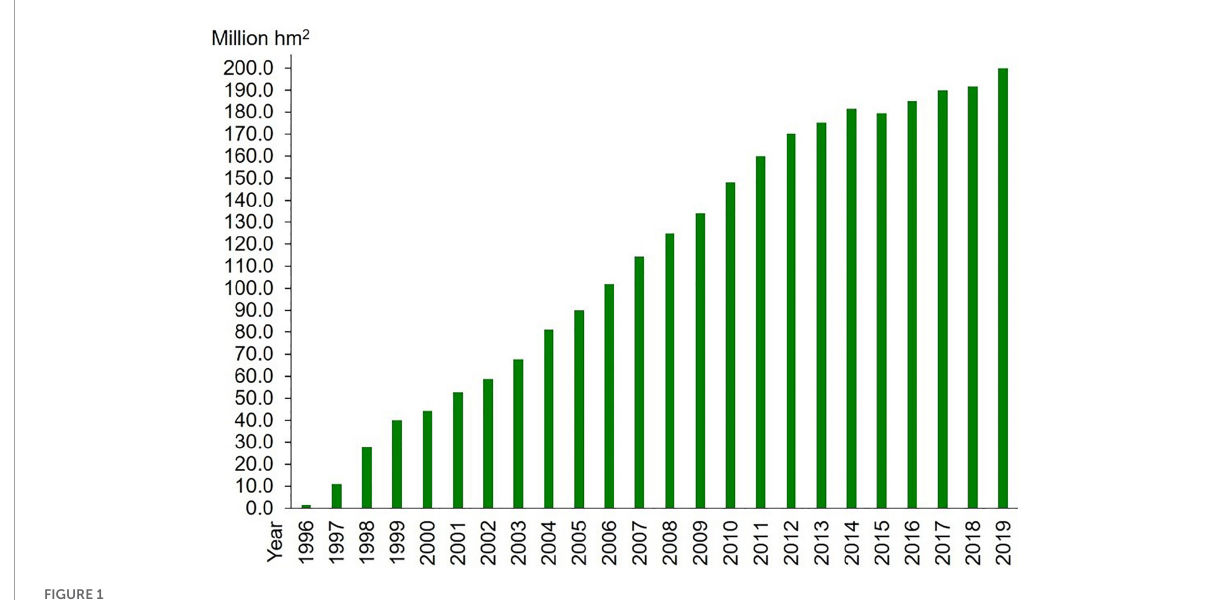
FIGURE1 Commercialized acreage of transgenic